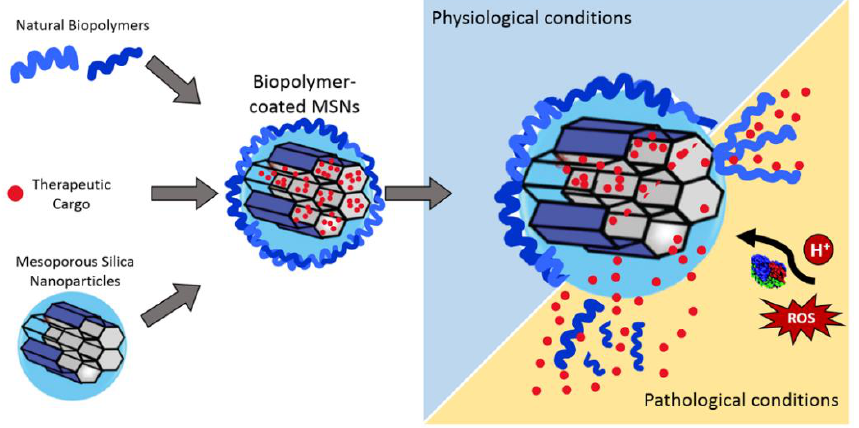
Scheme 1. Graphical representation of the concept of coating Mesoporous Silica